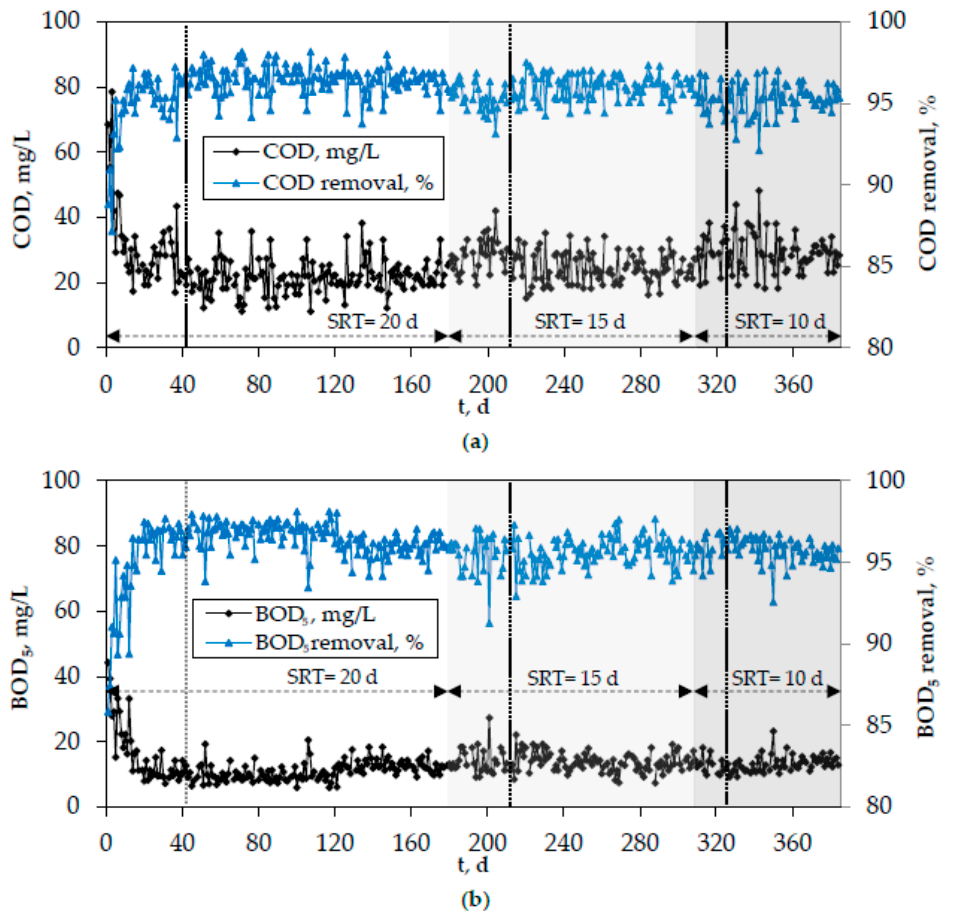
Figure 8. Evolution of ( a ) chemical oxygen demand (COD) και ( b ) biochemical oxygen demand (BOD) 5 in the e ffl uent of the lab-scale MBR and the respective removal